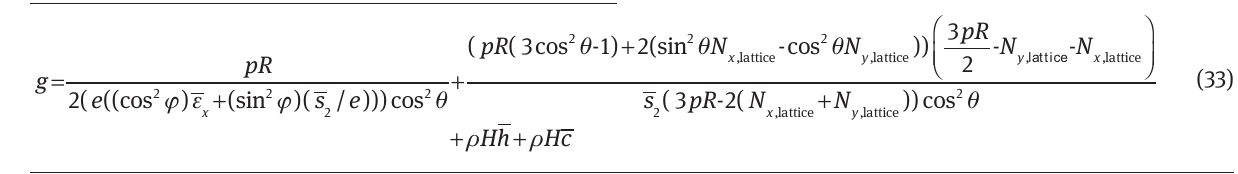
Figure 6 Dependency of the structure mass ( g ) on thickness ratio [ H /( h + h )] for various values of ( b / a ) under specified hoop con- 1 2 ε straint ( 0.5%). y